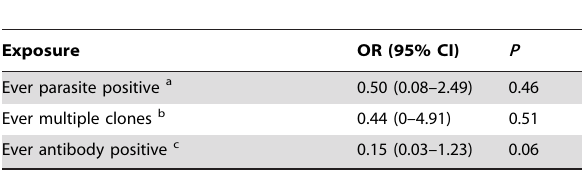
Table 4. Risk of impaired consciousness in relation to parasite exposure in three-monthly samples among 61 cases with severe